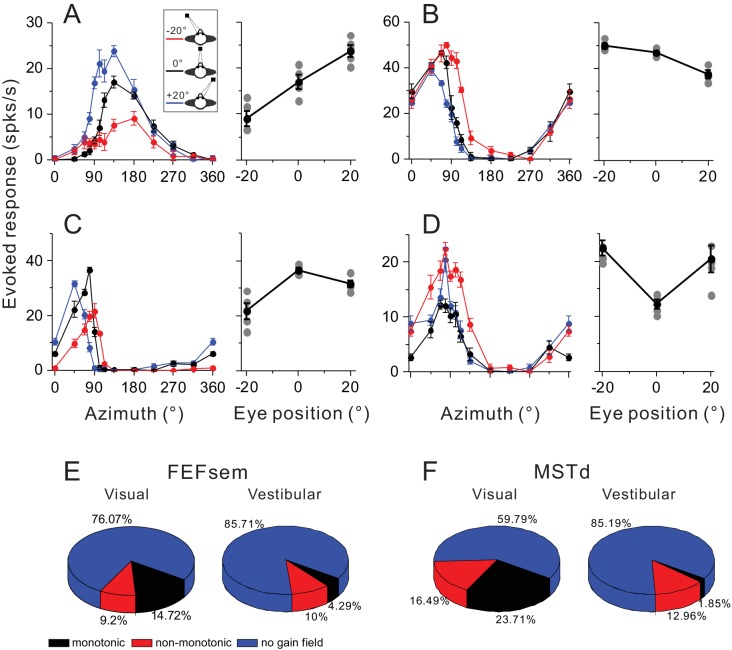
Gain modulations in FEFsem and MSTd.(A–D) Four example units with significant gain modulations across fixation locations. A and B show two cases with monotonic gain effect. In C and D, the effect is not monotonic, but rather that the responses are either strongest or weakest during central fixation. Tuning curves are the evoked responses with the minimum mean firing rate subtracted. Red, black and blue symbols represent eccentric fixation at −20°, 0° and 20°, respectively, and are the same for the rest of the figure. (E, F) Proportion of different category of neurons in the visual and vestibular conditions in FEFsem (E) and MSTd (F). Red: monotonic group; Black: non-monotonic group; Blue: no-gain modulations.